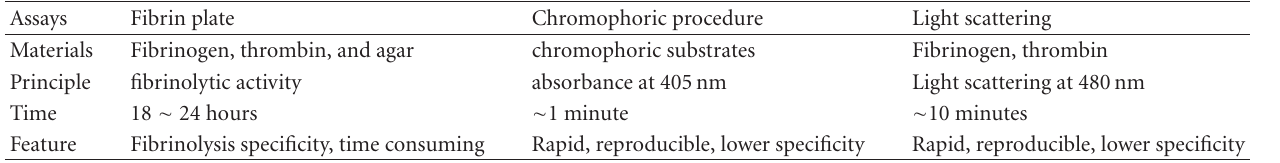
Figure 1: Localization and total relative activity of the earthworm segments: (a) nine pieces of the earthworm E. fetida (b) fibrin plate assay (c) enzymic activity of each segment (see [30]). Table 2: Three assays of the earthworm